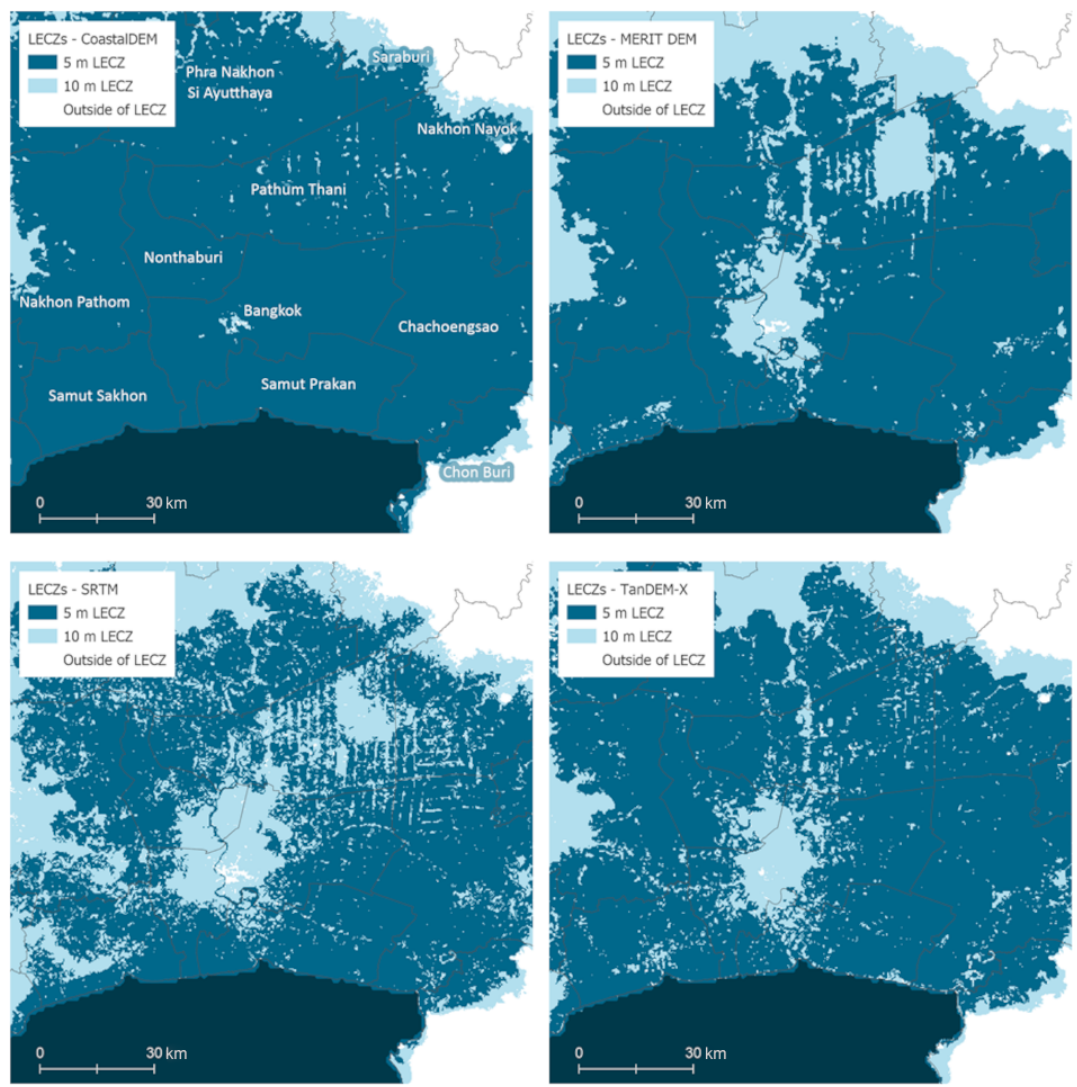
Figure 6. Low-elevation coastal zones (LECZs) constructed from source DEMs, Bangkok and surrounding areas, Thailand. Note that the darkest blue indicates ocean, and gray boundaries indicate first-order administrative